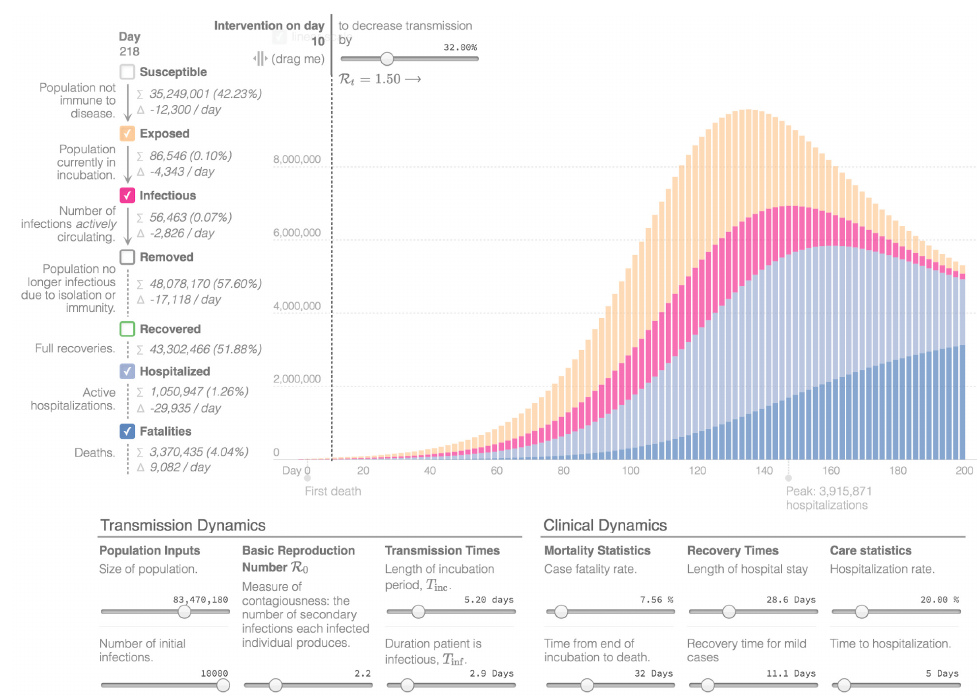
Figure 4. Epidemiological Curve 2 [7].